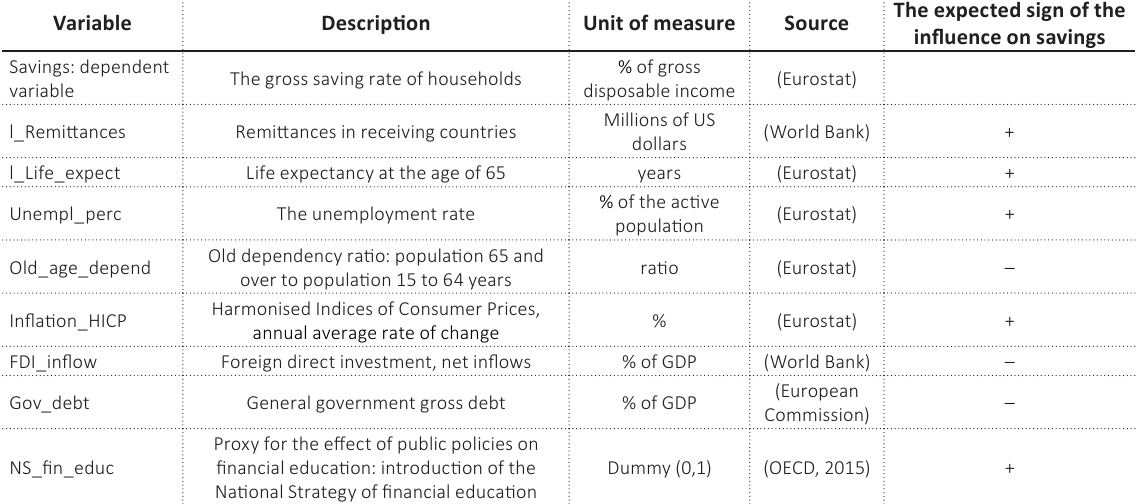
Source: Eurostat.